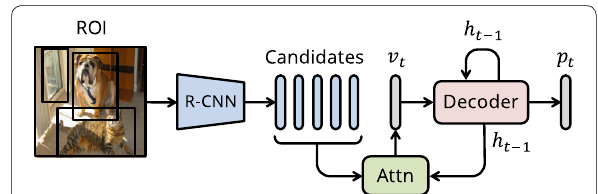
Fig. 3 Baseline model UpDpwn [20]. The block Attn denotes the attention module. v t and p t denote an attended feature and vocabulary logits at time step t , respectively. h t − 1 denotes the previous states of the RNN decoder